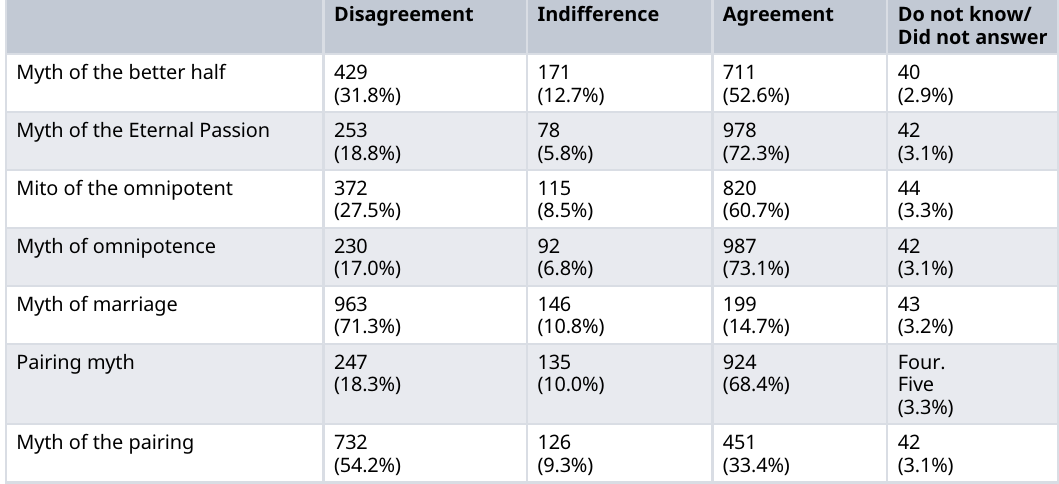
Table 2. Percentages of the number of people who believe the myths of romantic love in Spain. The total number of people interviewed is 1351 (Ferrer et al ., 2010, pp.11,